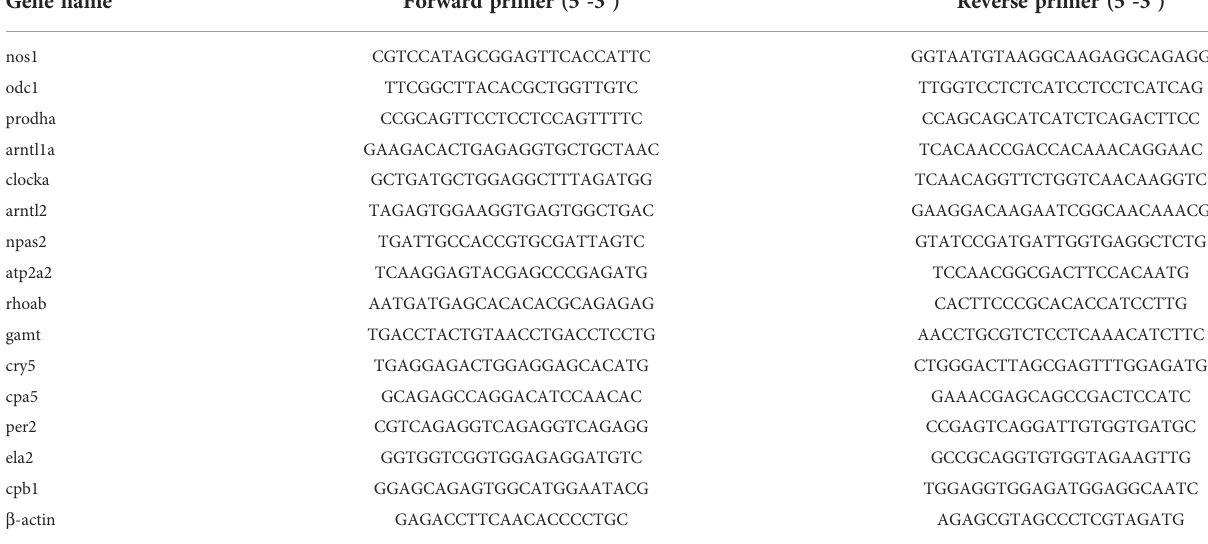
TABLE 1 List of primers used for this